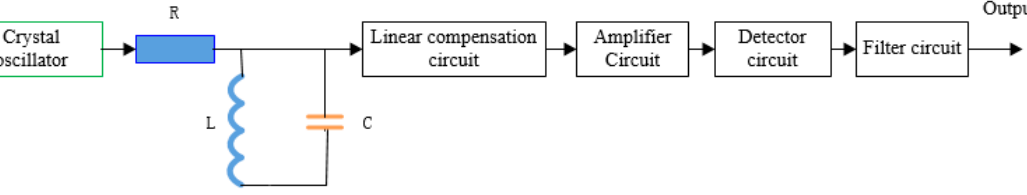
Figure 9. Schematic diagram of circuit structure.